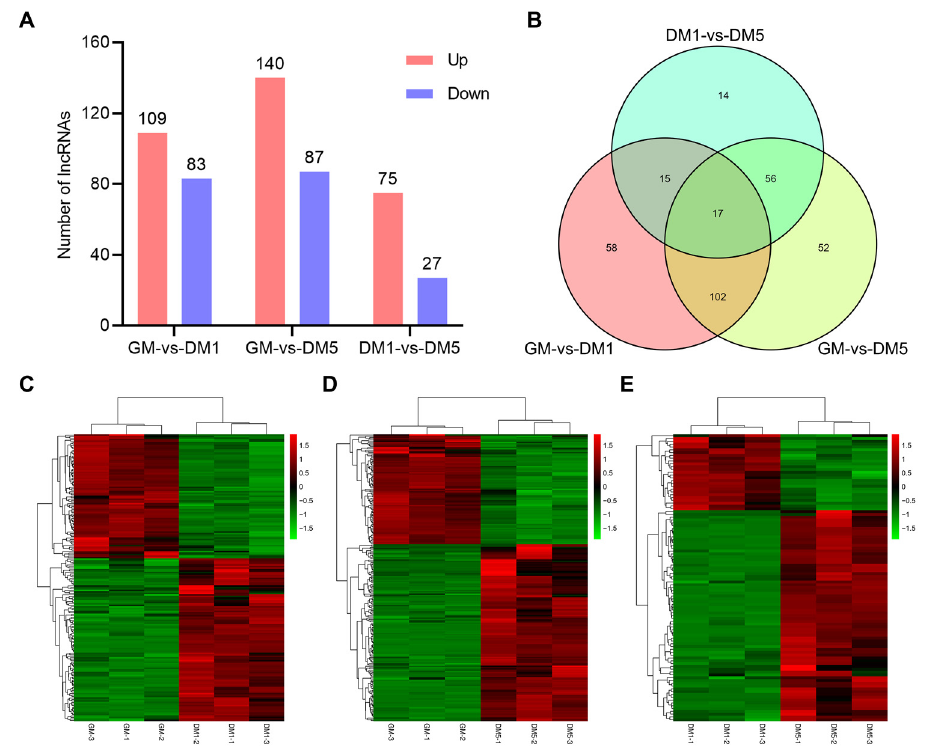
Figure 3. Analysis of DE lncRNAs. ( A ) Numbers of up-regulated and down-regulated lncRNAs. ( B ) Venn diagram showing the DE lncRNAs at the three comparisons. ( C – E ) Hierarchical clustering analysis of DE lncRNAs through pairwise comparisons. Red: relatively high expression; Green: relatively low expression.